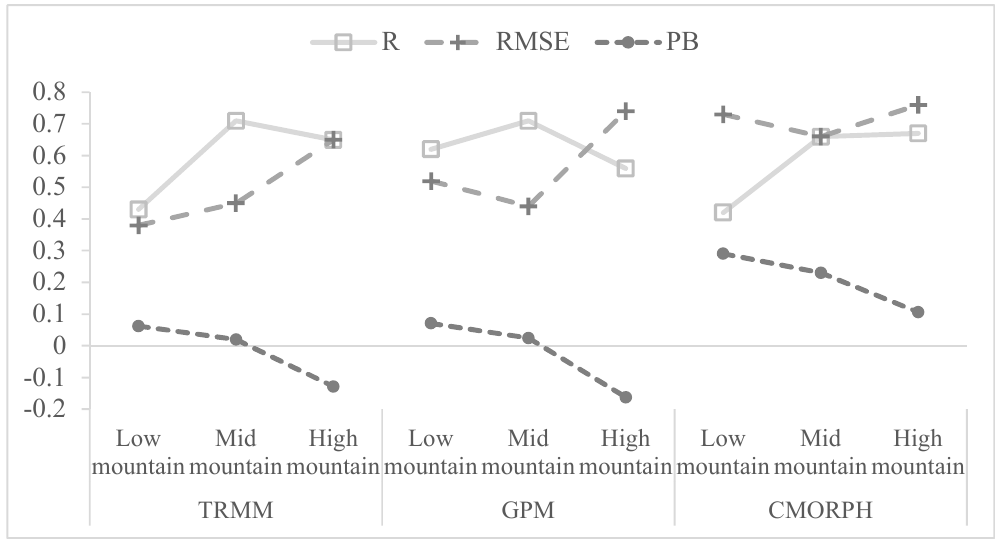
Figure 6. Comparison of the precisions of three satellite-based products at different elevation